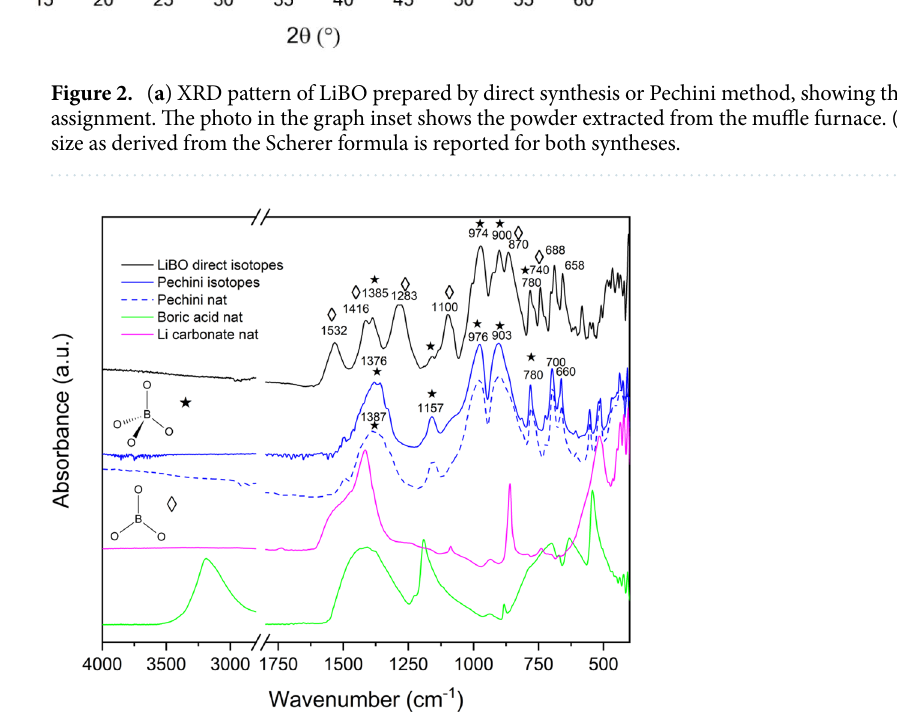
Figure 3. Infrared spectra collected in ATR mode of Lithium tetraborate obtained by direct synthesis or Pechini (Khalil) method. The spectra of precursors are also reported for